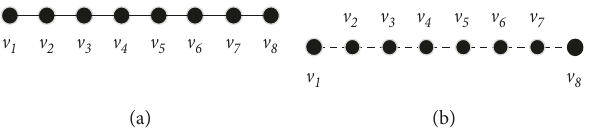
Figure 2: Illustration of observation 1. (a) Original edge. (b) Virtual